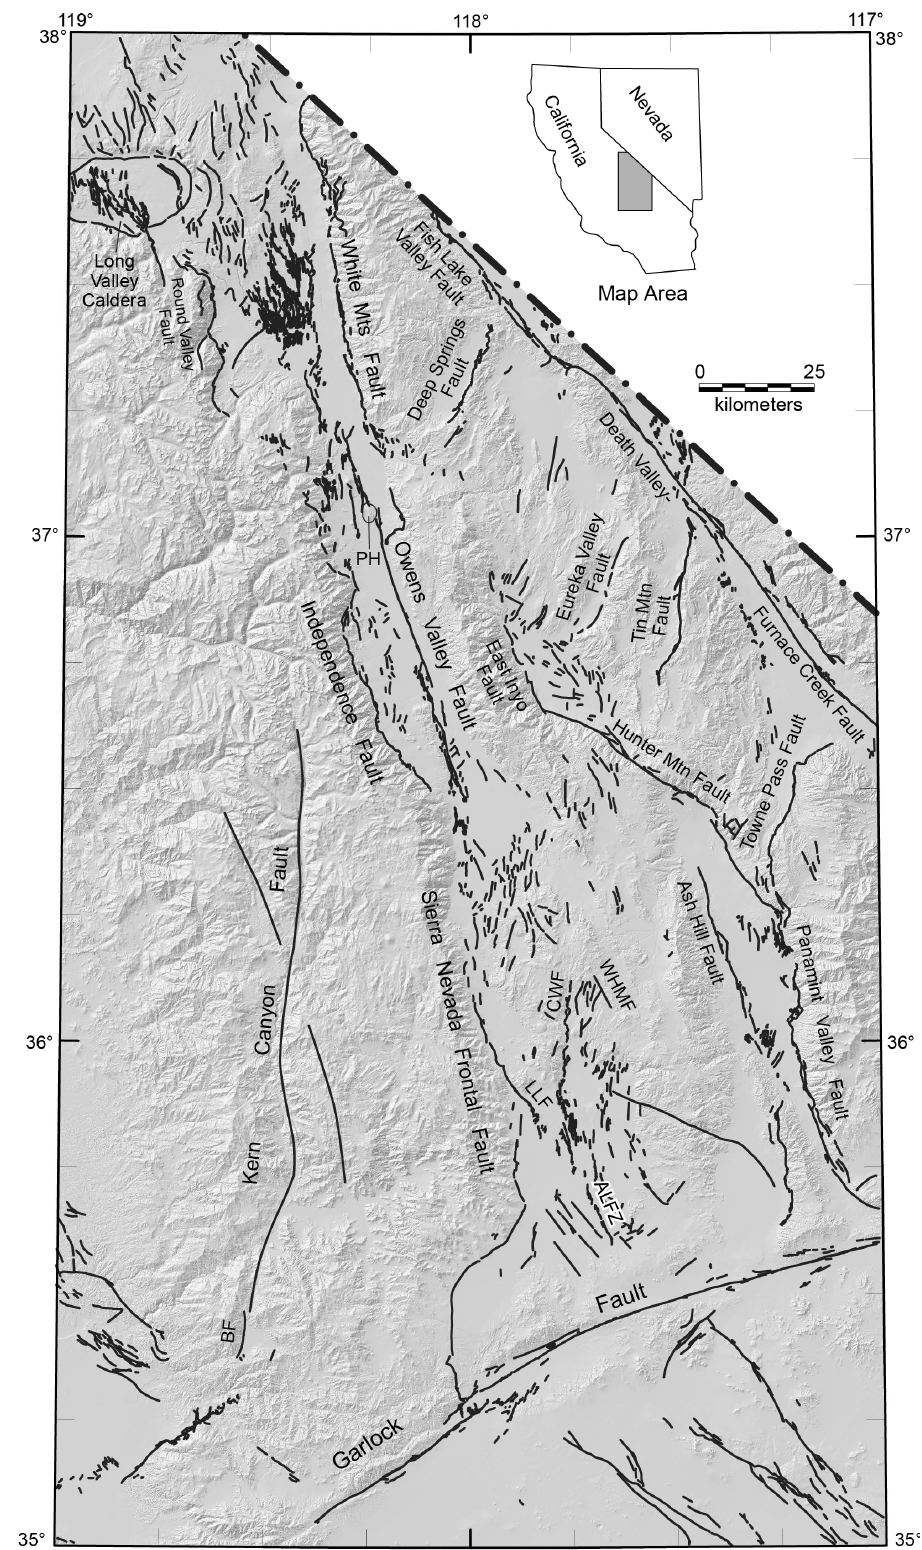
Figure 3. Map showing Quaternary faults in east-central California [39,50]. Abbreviated fault names are as follows: ALFZ = Airport Lake Fault Zone; BF = Breckenridge Fault; CWF = Coso Wash Fault; LLF = Little Lake Fault; PH = Poverty Hills; WHMFZ = Wild Horse Mesa Fault Zone